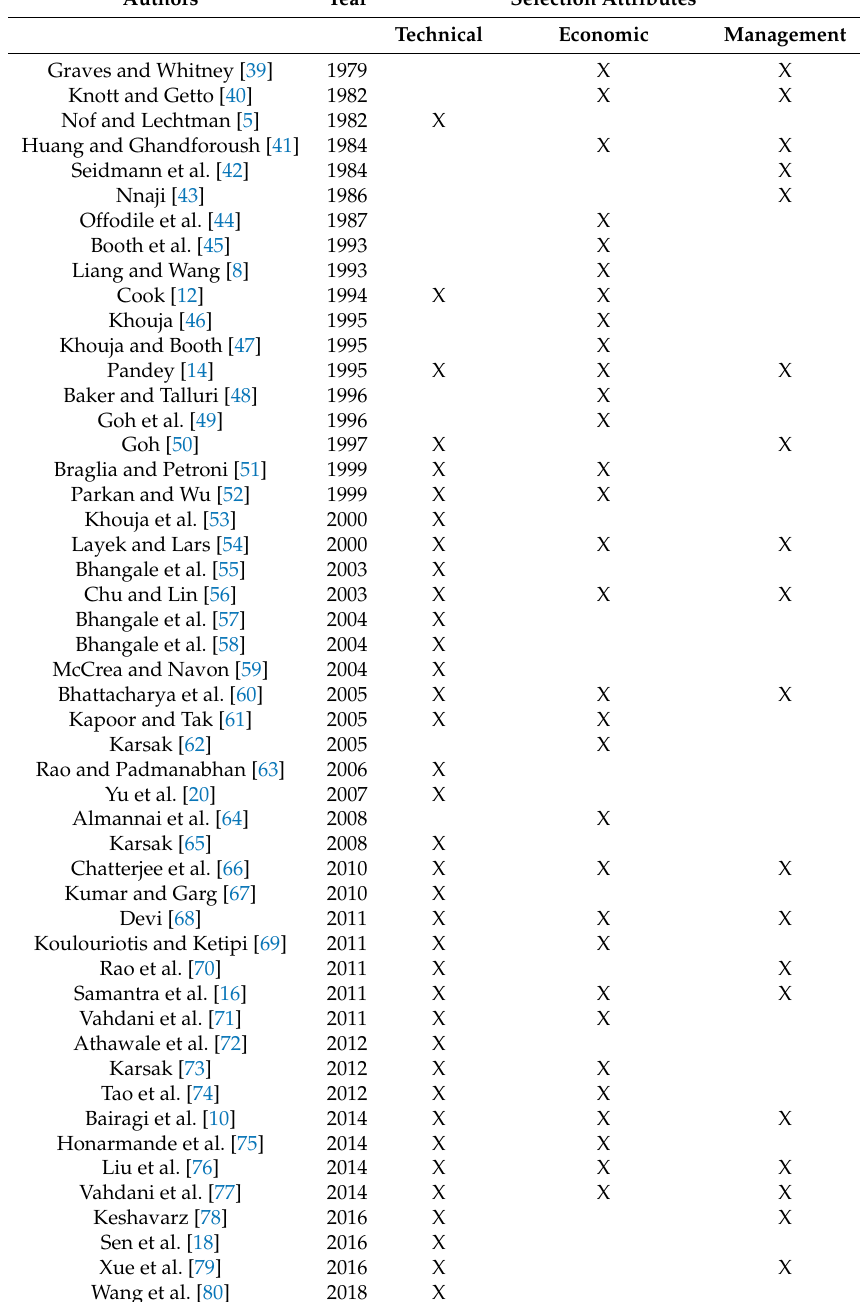
Table A1. List of the papers included in the review of the RSP literature, and classification assigned to the investigated